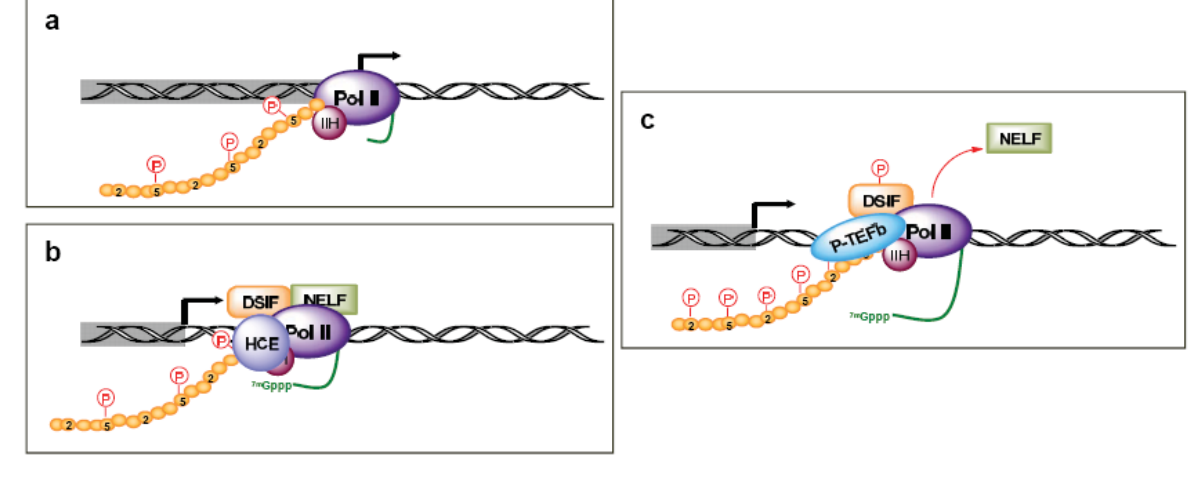
Figure 2. Schematic diagram of promoter clearance and the transition to an elongation complex. ( a ) Promoter clearance, with the phosphorylation of serines at position 5 of the C-terminal domain (CTD). ( b ) Recruitment of 5,6-dichloro-1- β -d-ribofuranosylbenzimidazole (DRB) sensitivity-inducing factor (DSIF) and negative elongation factor (NELF) to induce pausing of Pol II and the binding human capping enzymes (HCE) to generate a 5′ m7G cap on nascent transcripts. ( c ) Recruitment of P-TEFb with the phosphorylation of serines at position 2 in the CTD, followed by productive elongation. Phosphorylation of DSIF and Pol II on Ser2 and 5 in the heptapeptide repeats of the CTD are depicted by red letters in red circles. The nascent transcript is depicted as a green